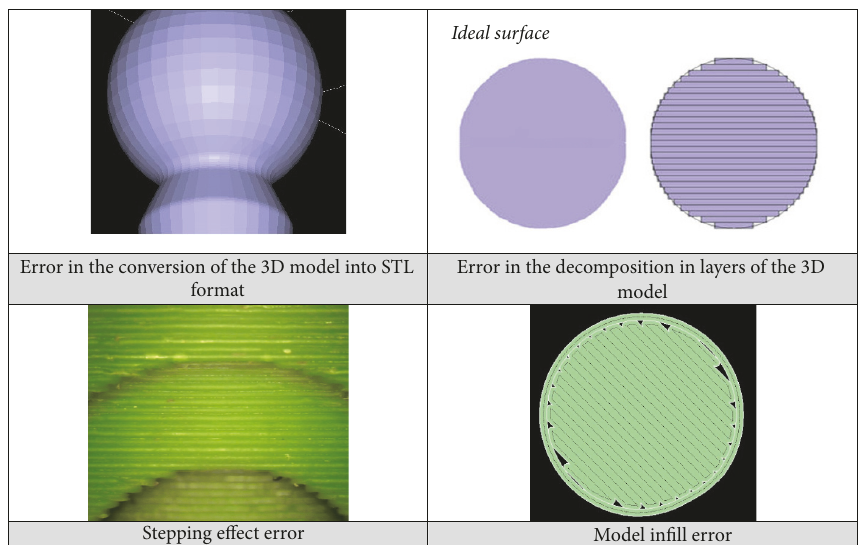
Figure 5: Technology limitations in the rapid prototyping process.